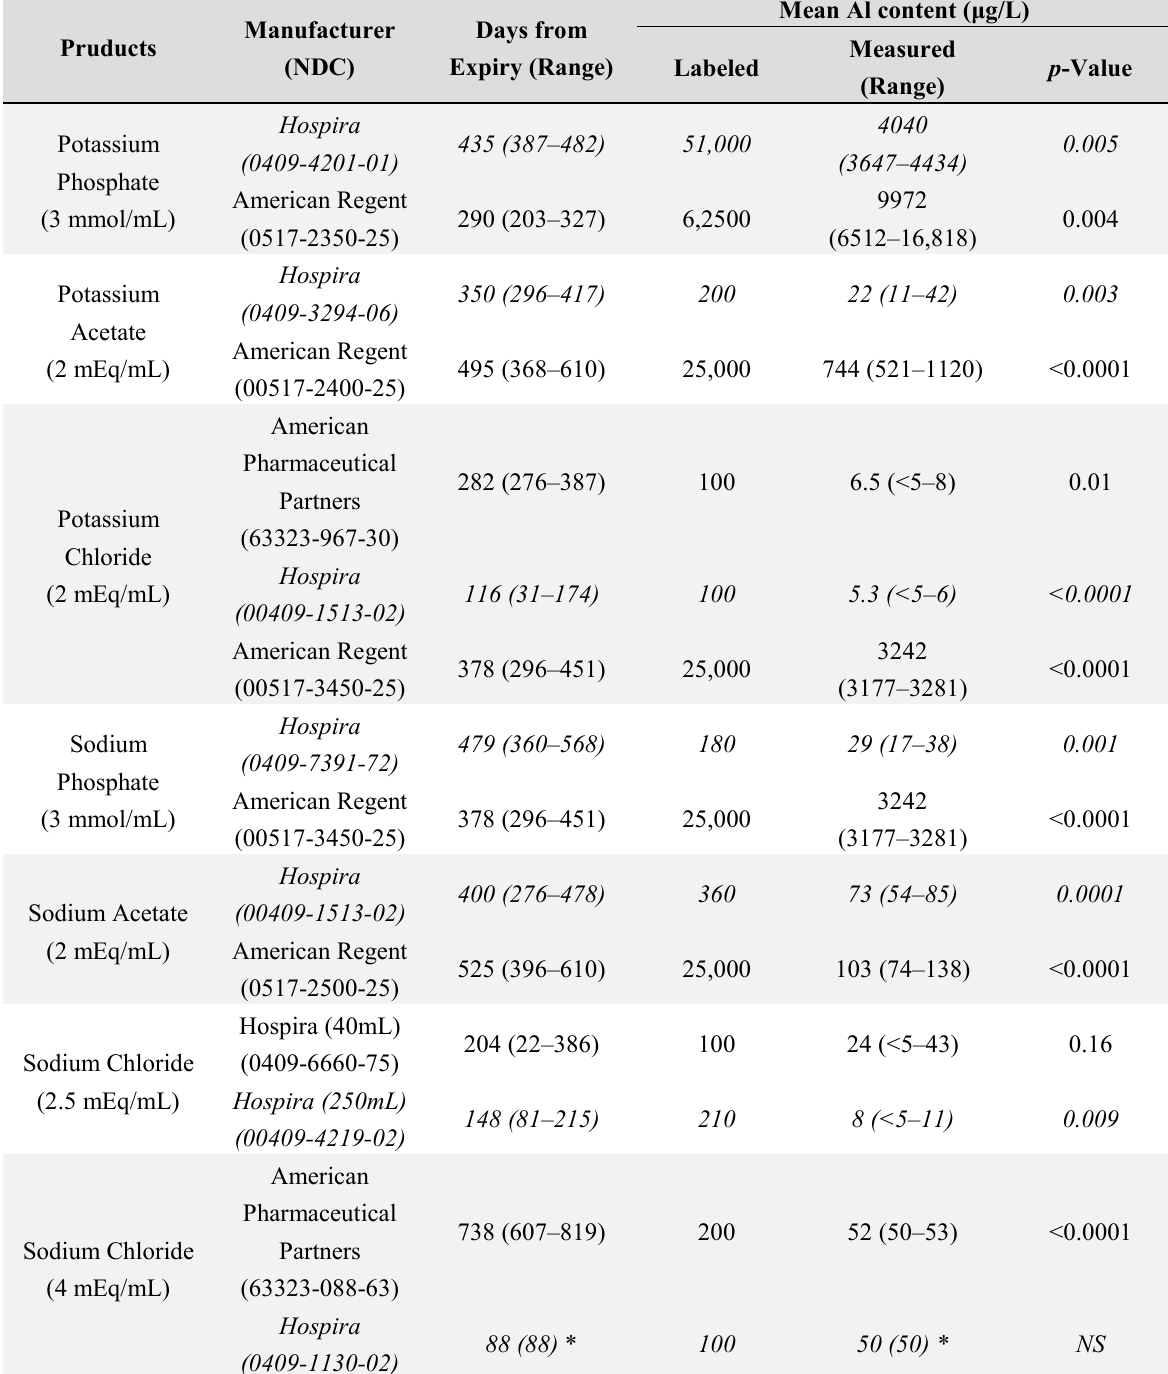
Table 2. Aluminum content of potassium and sodium products used in parenteral nutrition solutions. Reprinted with permission from